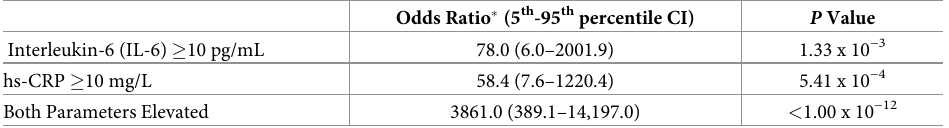
Table 3. Prediction of need for hospitalization among SARS-CoV-2 RNA positive